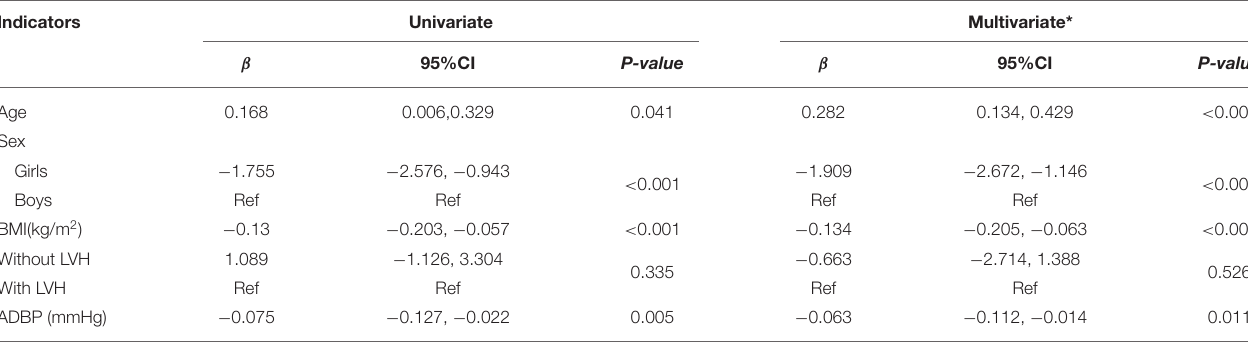
TABLE 6 | Multivariate analysis regarding METs in children with PHT.